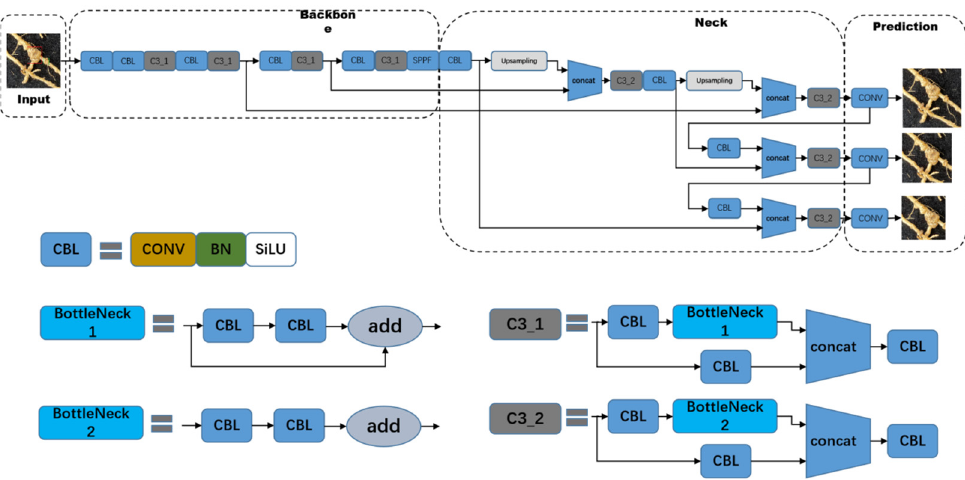
Figure 3. The YOLOv5 network structure.